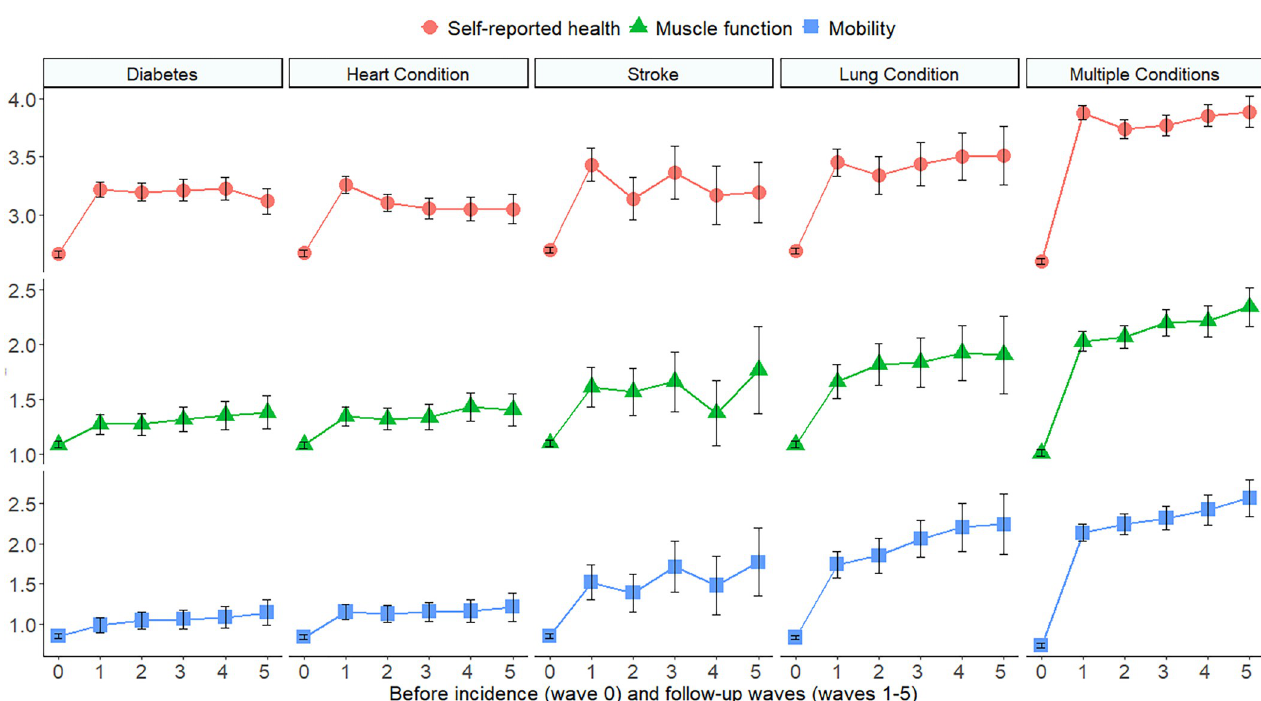
Fig 1. Means of self-reported health, large muscle function, and mobility by chronic diseases. Error bars are 95% confidence intervals obtained from piece- wise linear regression models. Waves are follow-up intervals roughly two years apart. Patients initially free of the listed chronic conditions were followed from before incidence though five waves after incidence. Patients were analyzed as having single conditions until a second occurred. Subsequently, the patients were treated as having multiple chronic conditions.